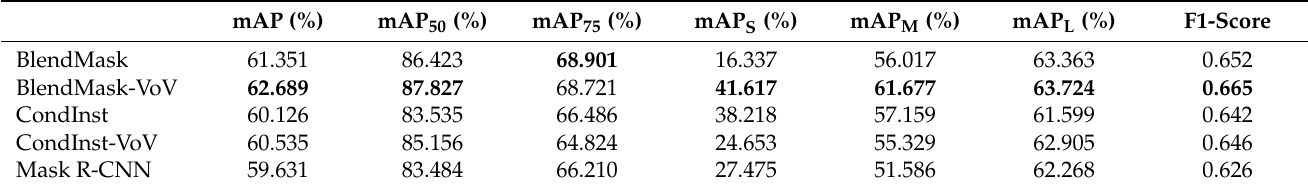
Figure 5. P-R curves of the validation and test sets from the KOMMA dataset. ( a ) The P-R curves of validation set in the bounding box detection task; ( b ) the P-R curves of validation set in the segmentation task; ( c ) the P-R curves of test set in the bounding box detection task; ( d ) the P-R curves of test set in the segmentation task. Table 2. Quantitative Evaluation of the validation set in the bounding box detection task.